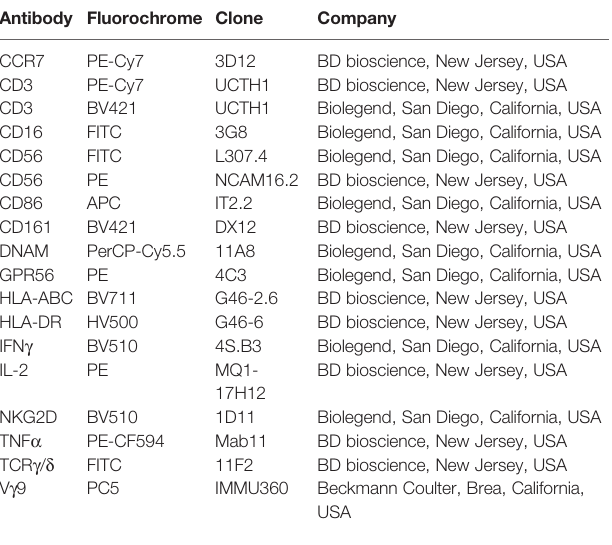
TABLE 1 | List of antibodies used in this study. Antibody Fluorochrome